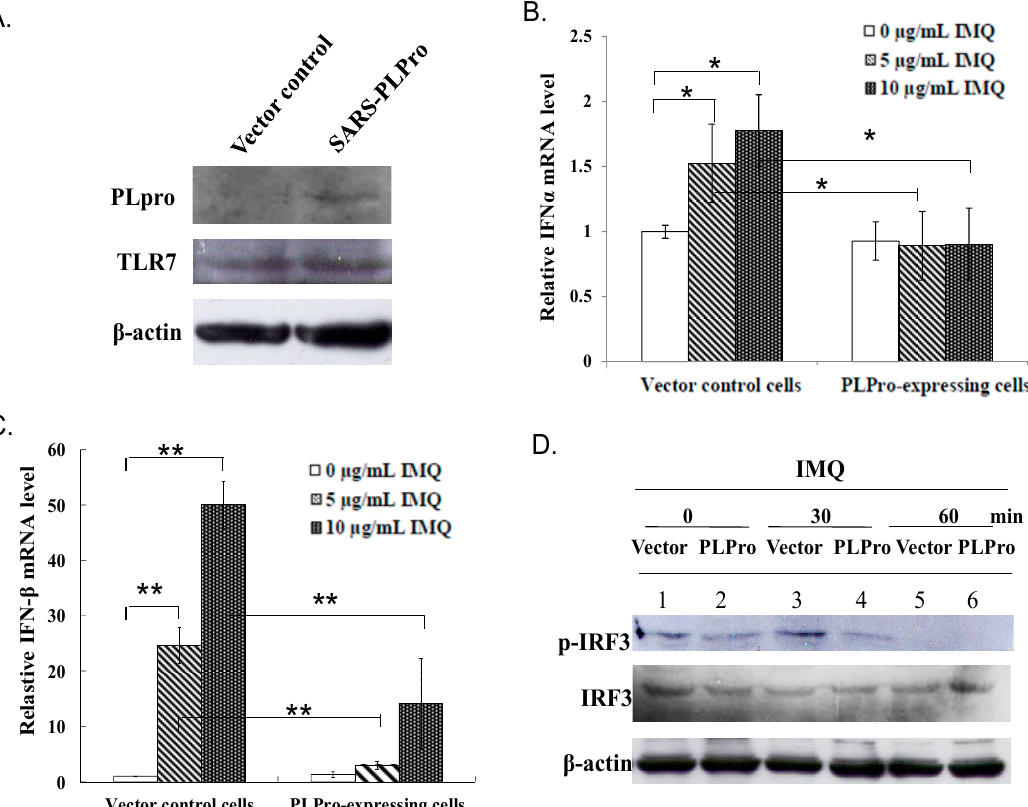
Figure 1. Effect of SARS-CoV PLPro on TLR7 agonist-induced production of type I IFNs via IRF3 signaling. The expression level of PLPro and TLR7 in the vector control and PLPro-expressing cells was analyzed using Western blot assay ( A ). Both types of transfected cells were treated with or without imiquimod (IMQ) for 4 h, and then, their mRNA levels of IFN- α and IFN- β were measured by quantitative PCR. Relative mRNA levels of IFN- α ( B ) and IFN- β ( C ) were normalized by GAPDH mRNA, presented as a relative ratio. To determine IRF3 activation, the lysates were also analyzed using Western blot with anti-phospho-IRF3 antibodies ( D ). * p -Value < 0.05; ** p -value < 0.01 by Student’s t -test.